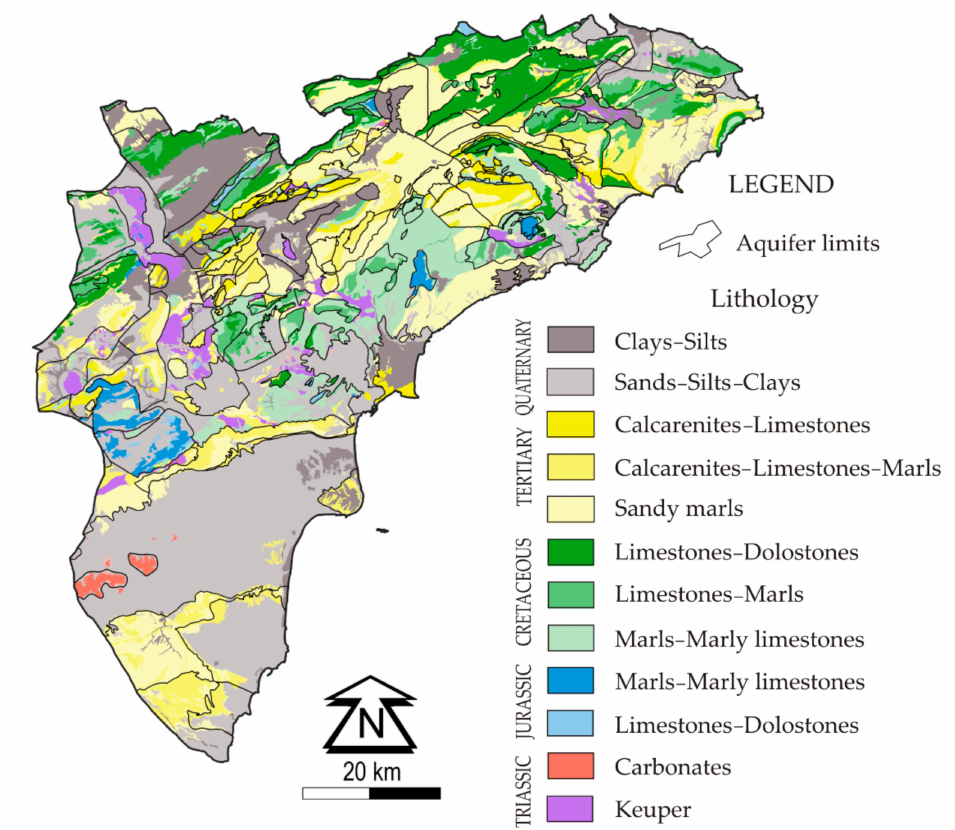
Figure 3. Map of main geological formations in the Alicante